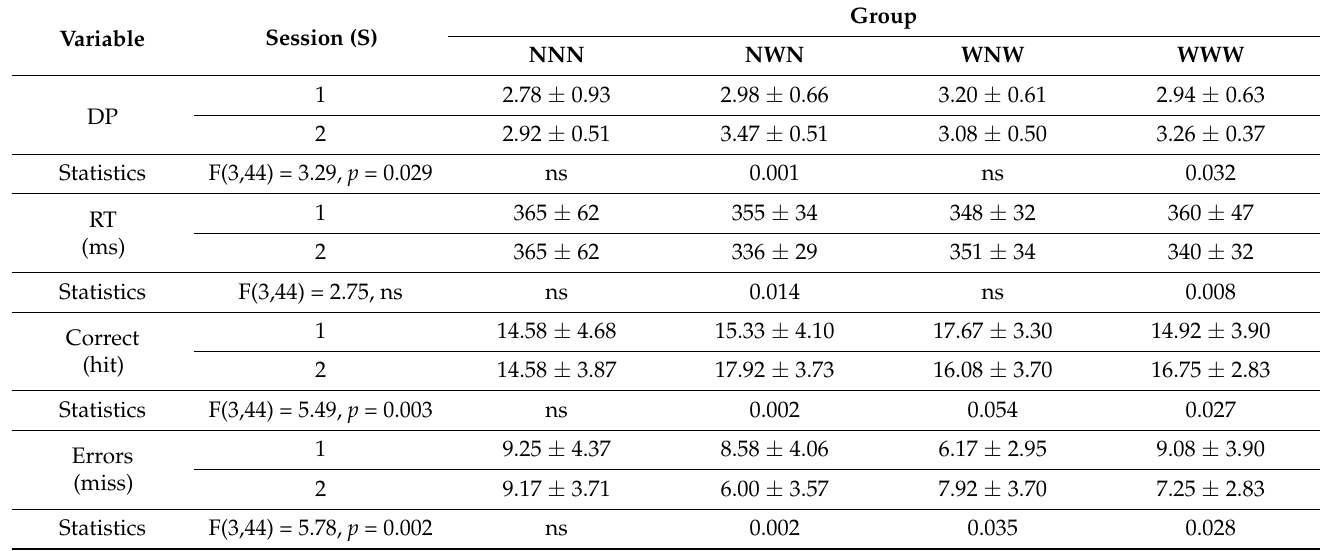
Table 4. Mean number ( ± standard deviation) of sensitivity (DP), reaction times (RT), and correct and incorrect (errors) responses in Session 1 (before the break) and in Session 2 (after the break) for NNN, NWN, WNW, and WWW groups (N = not-wood room; W= wood room; ns=